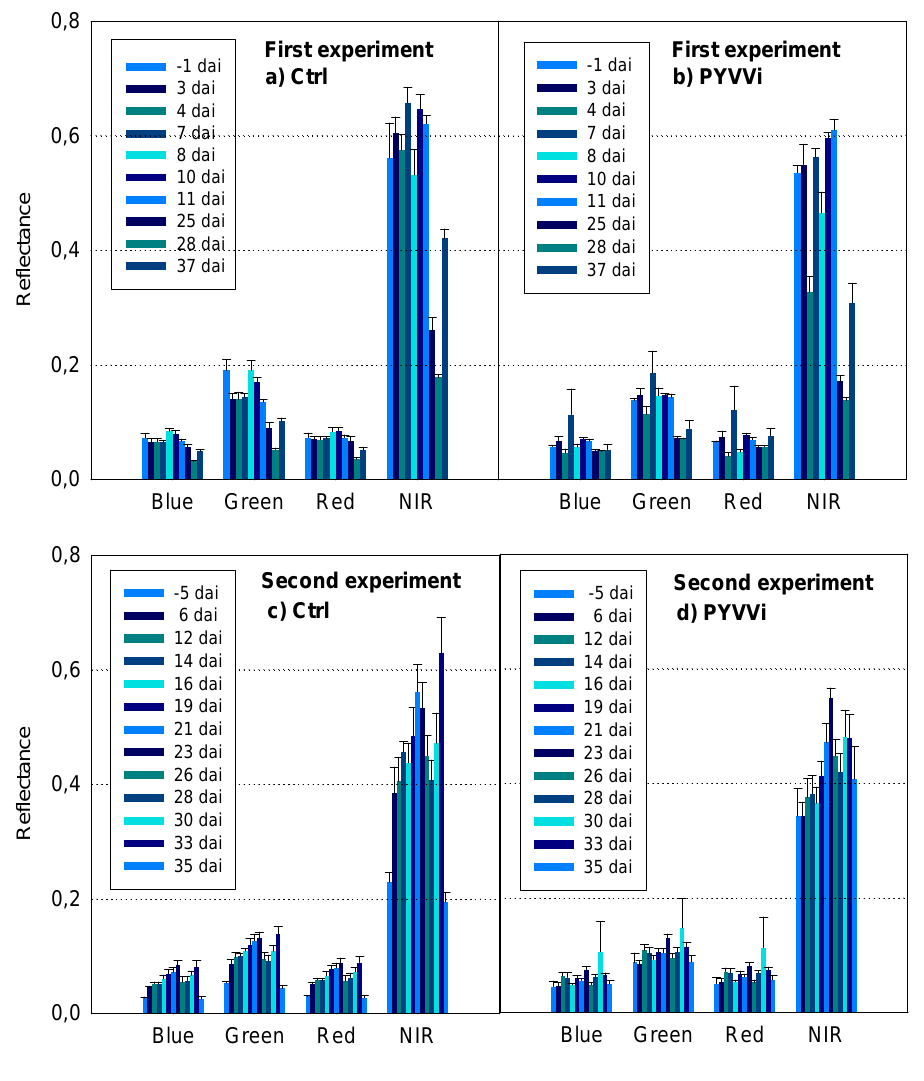
Figure 6. Analysis of discrete bands (blue, green, red and NIR) of reflectance spectra from plants. In the first experiment, ( a ) and ( b ), the difference between treatments was evident at the 25th day after infection. For the second experiment, ( c ) and ( d ), the difference between treatments was noticed on the 23rd day after